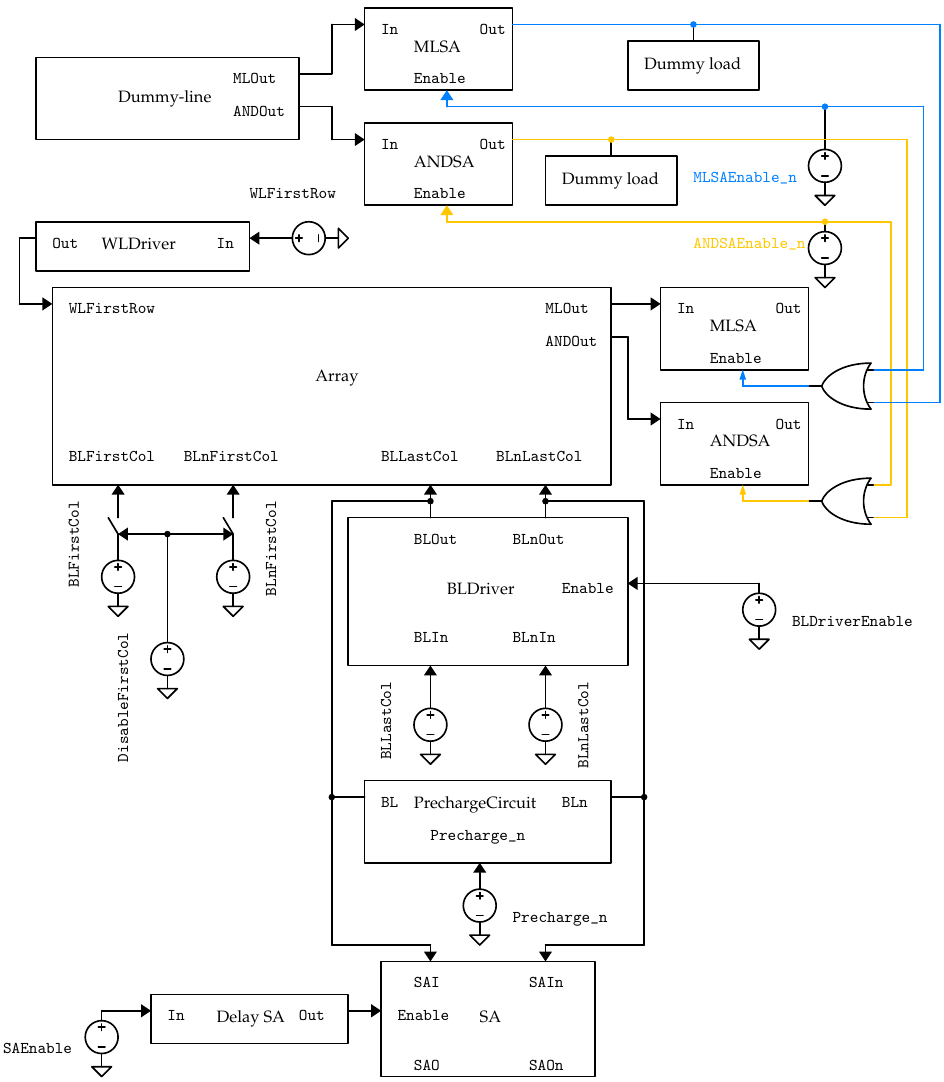
Figure 15. The testbench. The wires related to the CAM and AND functionalities are highlighted in blue and orange, respectively, for the sake of